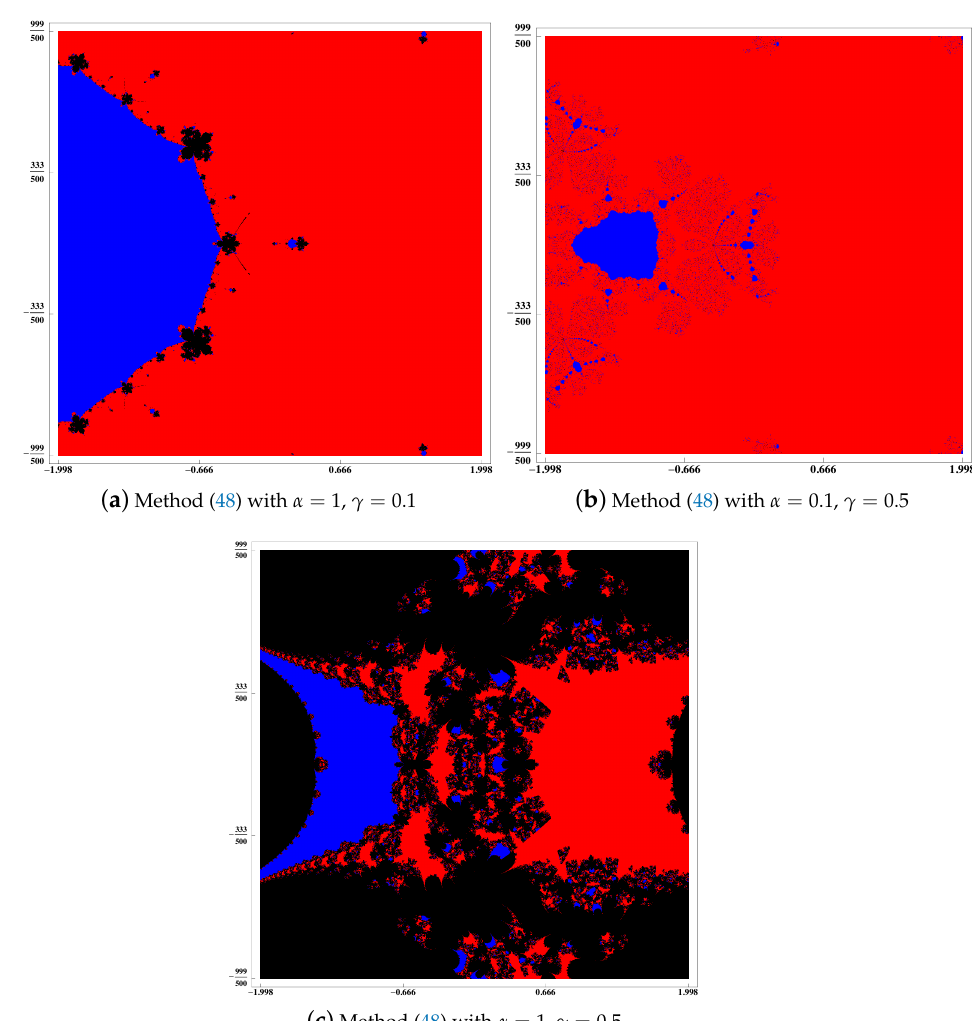
Figure 1. Basins of attraction associated to the method (48) applied to polynomial p ( z ) = ( z − 1 ) 2 ( z + 1 ) with different values for tolerance.